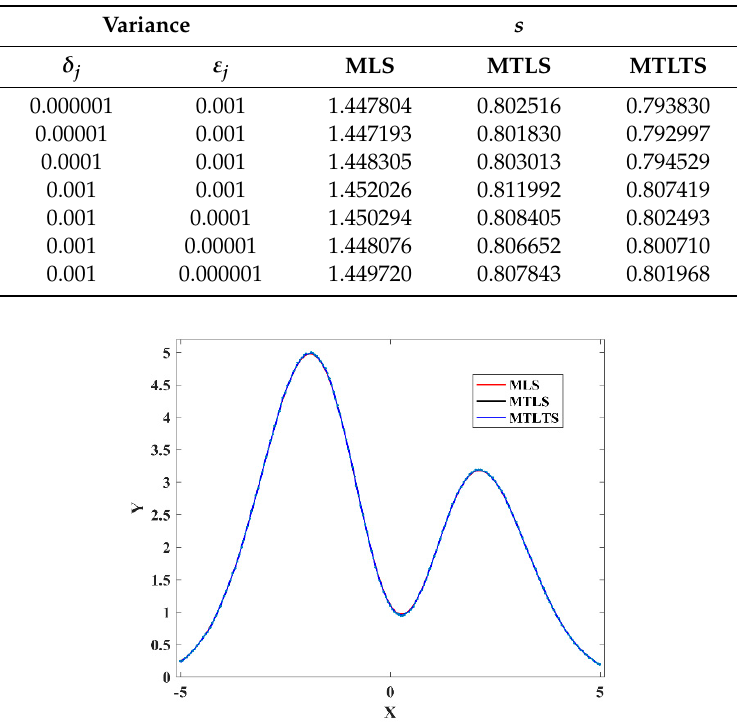
Table 4. The results of three methods for the data without outliers.